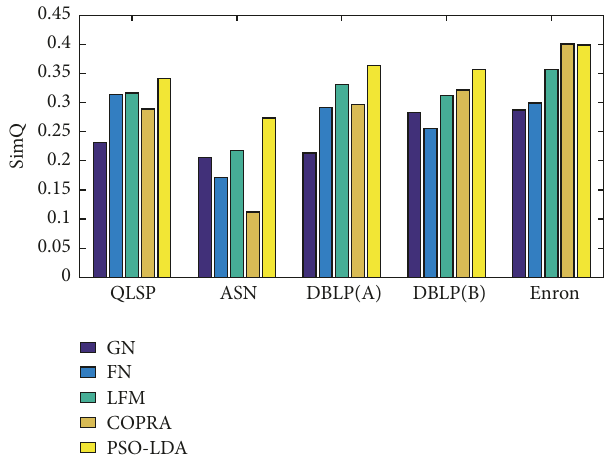
Figure 12: The histogram of 𝑆𝑖𝑚𝑄 with various classical algorithms. Table 3: The results of classical nonsemantic algorithms under various